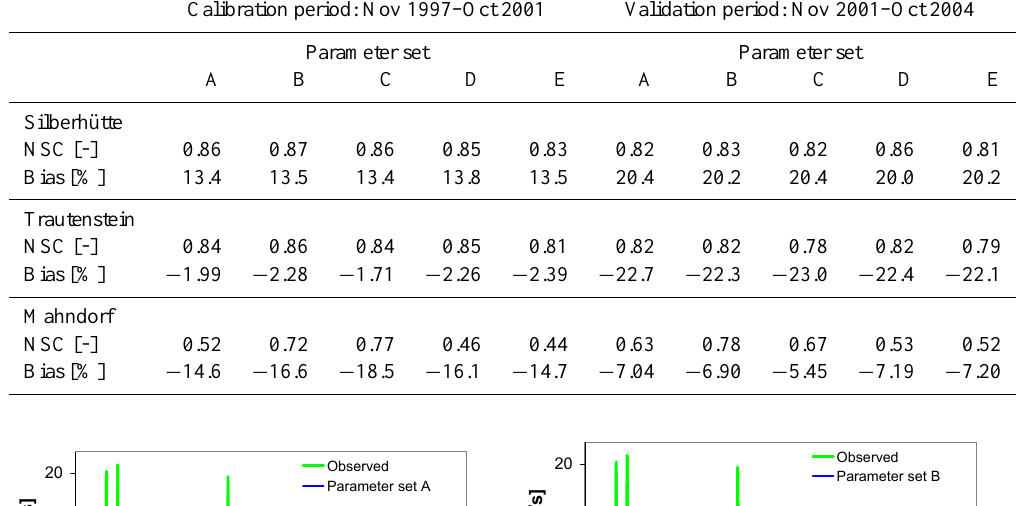
Table 4. Validation of the calibrated parameter sets using the Nash–Sutcliffe criterion (NSC) and the bias.